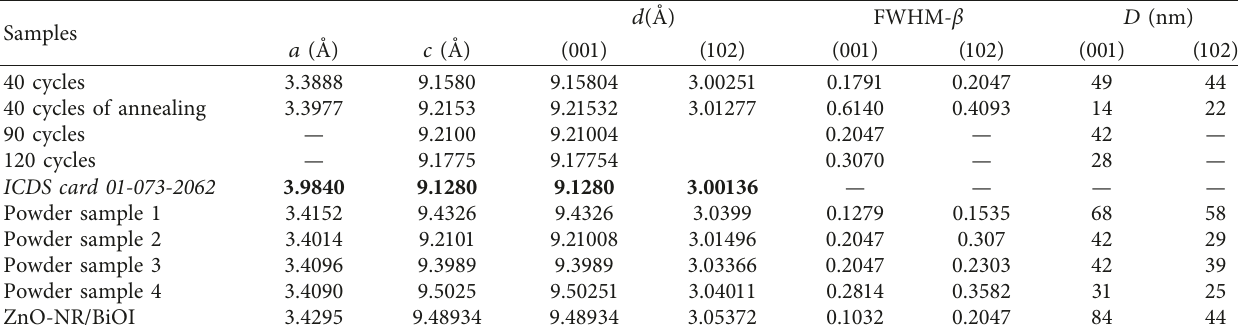
Figure 5: Diffraction pattern corresponding to decorated ZnO nanorods. Table 1: Lattice parameters, interplanar spacing, and crystallite size measured for all